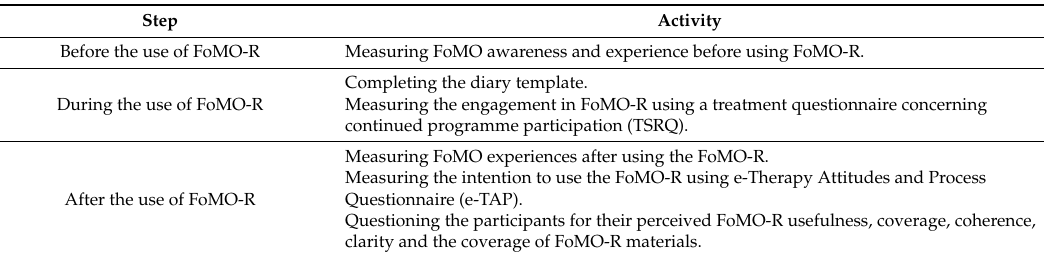
Table 6. FoMO-R evaluation